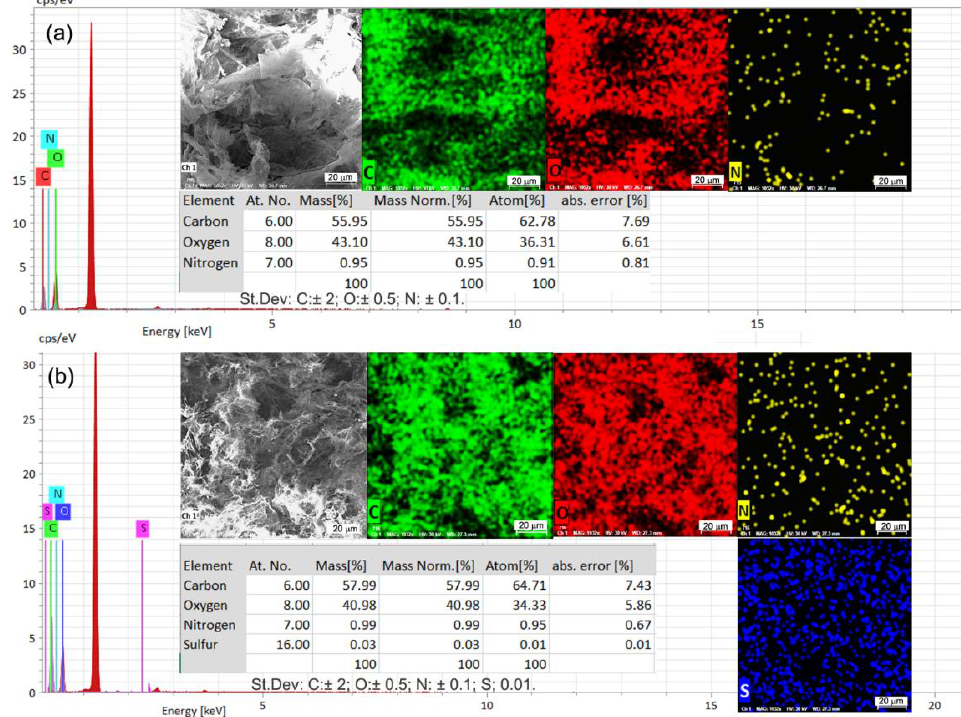
Figure 4. Energy-dispersive X-ray (EDX) spectra of the biosorbent OxC25 after ( a ) and before ( b ) Methylene Blue cationic dye biosorption.